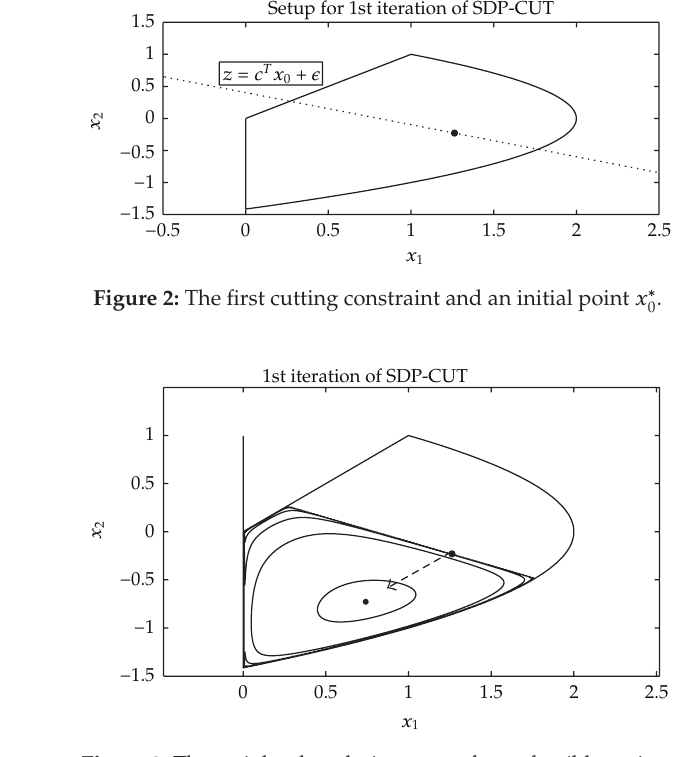
Figure 3: The weighted analytic center of new feasible